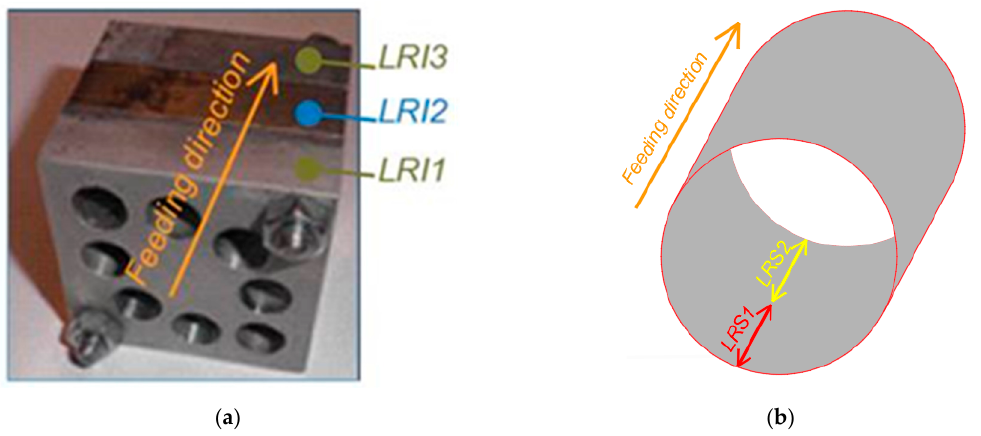
Figure 3. The concrete locations of the measurement zones of the surface roughness: ( a ) location relative to the insert, LRI; ( b ) location relative to the specimen, LRS.